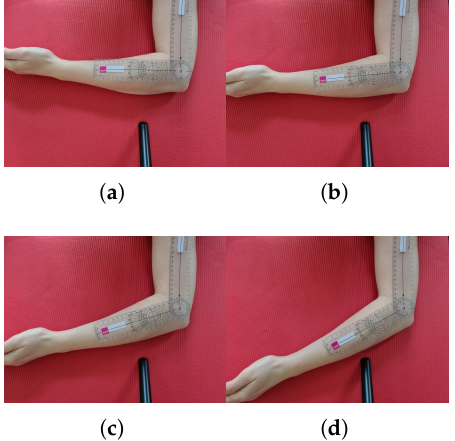
Figure 21. Elbow flexion from 90 ◦ to 120 ◦ in 10 ◦ increments measured with a goniometer. ( a ) 90 ◦ ; ( b ) 100 ◦ ; ( c ) 110 ◦ ; ( d ) 120 ◦